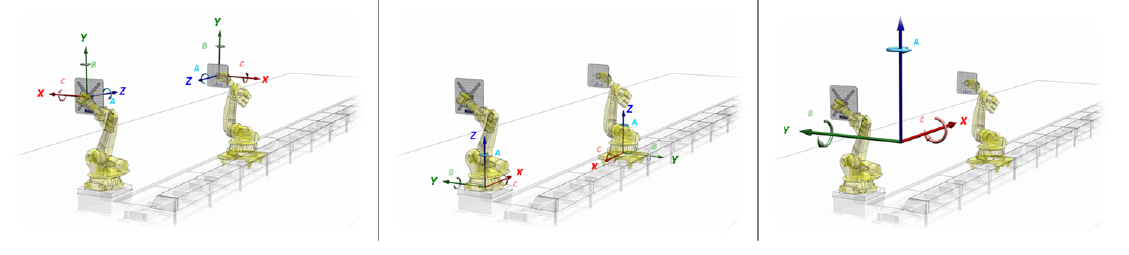
Figure 7: Coordinate Systems: Tool (left) and Base Coordinate System (center), and Global Lab Coordi- nate System